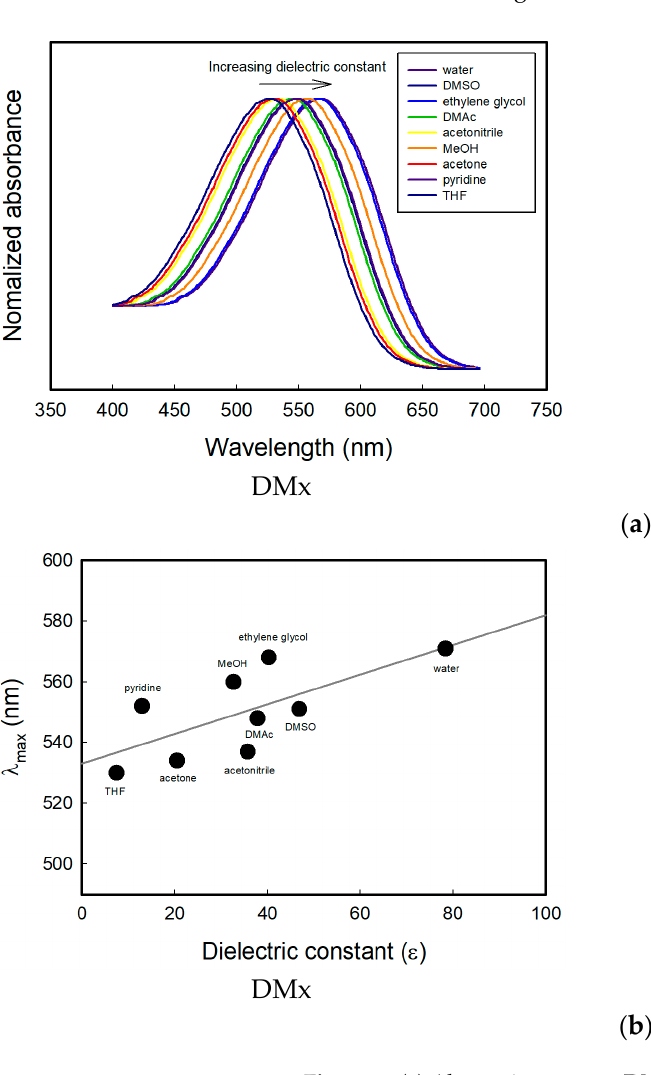
Figure 7. ( a ) Absorption spectra DMx and DM dissolved in various solvents with different dielectric constants, ( b ) relationship between the maximum absorption wavelength and solvent dielectric constant.